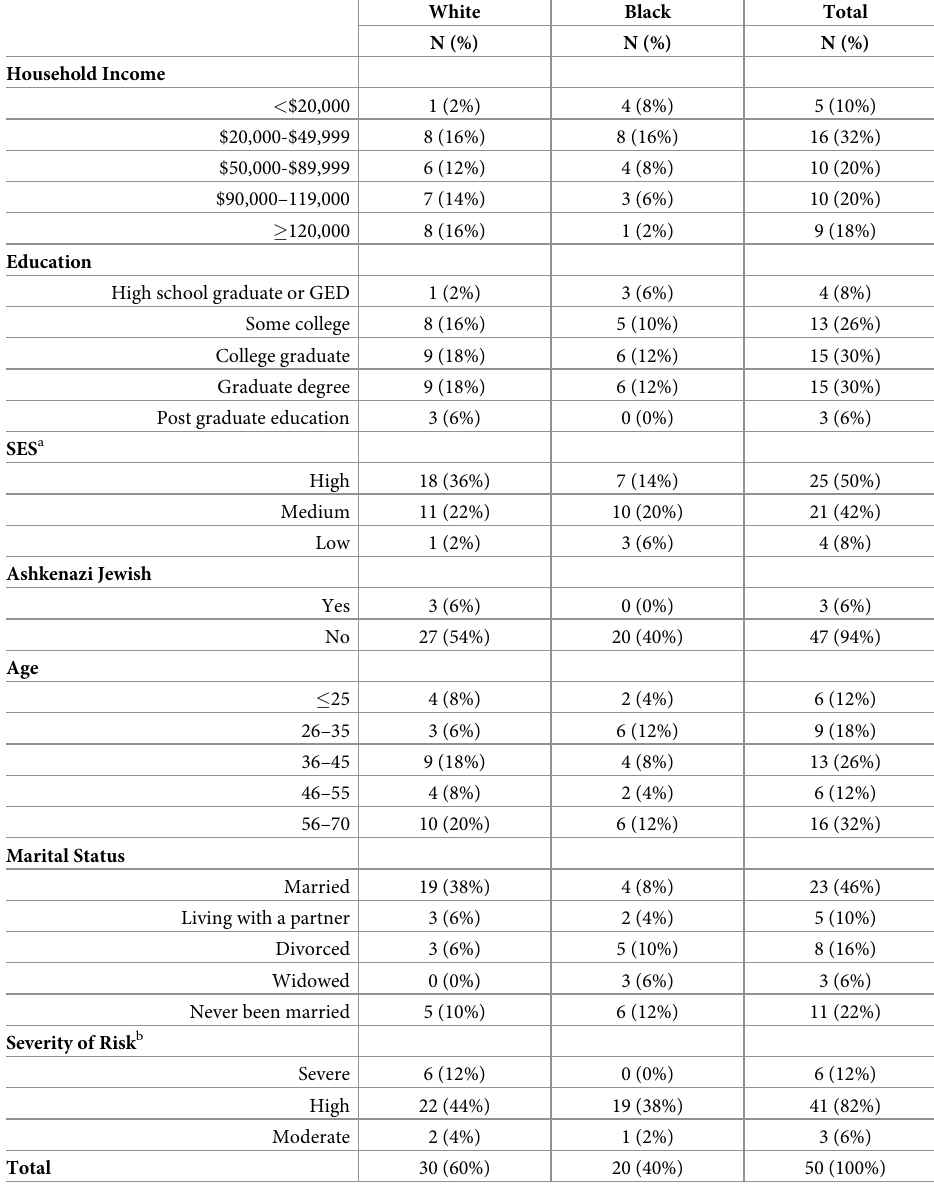
Table 1. Sample demographics.